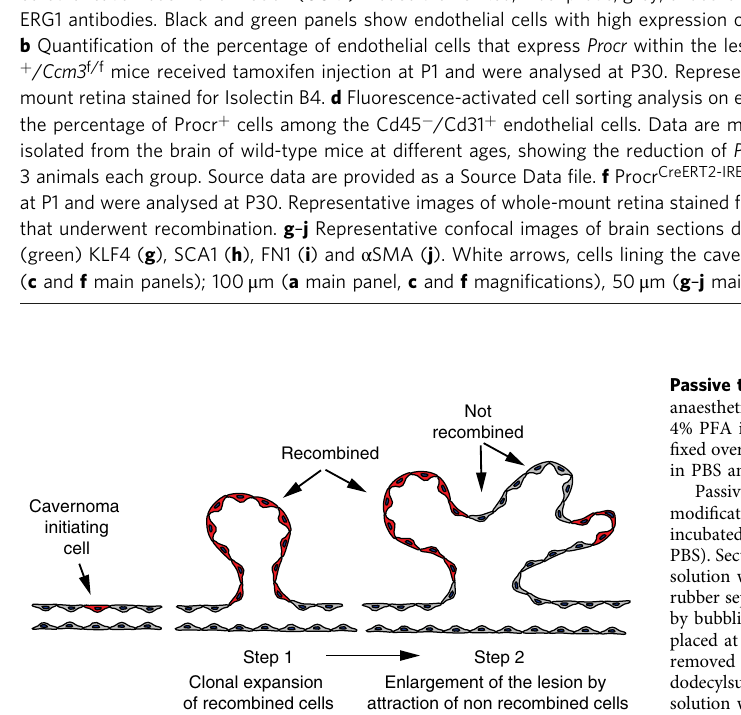
Fig. 9 Model for the onset and growth of cavernomas. Cavernoma-initiating cells undergo clonal expansion in response to Ccm3 loss and start to form cavernomas. In the further step, recombined cells recruit normal cells, which in turn, contribute to cavernoma